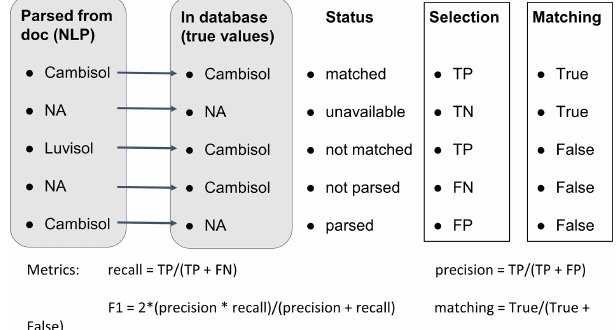
Figure 2. Cases of NLP extraction results in regards to the value entered in the database (considered the correct values) for the se- lection task and the matching task. TP, TN, FN and FP stand for true positive, true negative, false negative and false positive, respec- tively. The recall, precision, F1 score and matching values served as metrics for each